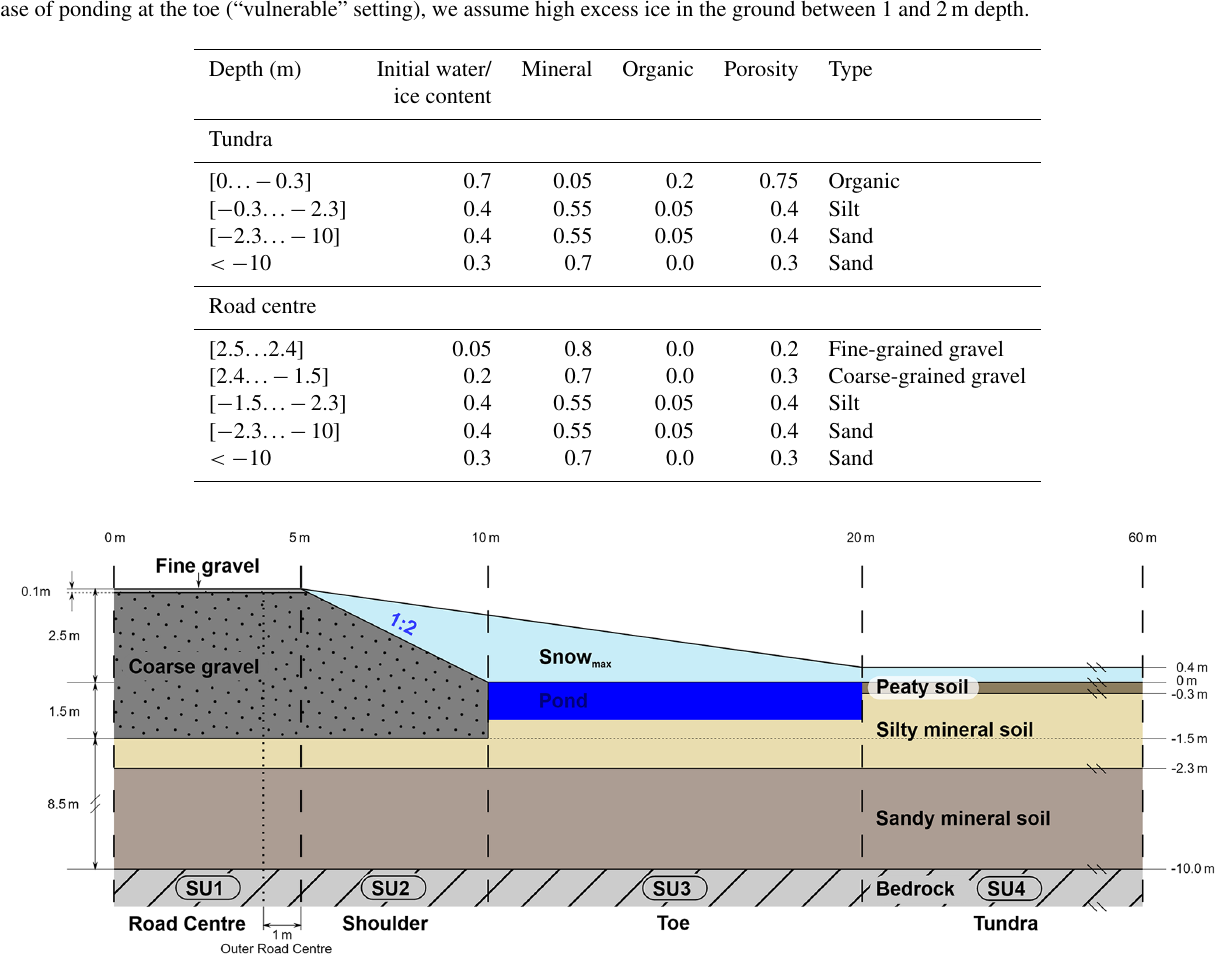
Table 1. Ground stratigraphies with volumetric fractions of the ground constituents. Negative depths correspond to layers elevated relative to the tundra surface at 0m. The setting for the road shoulder is identical to the road centre, besides lacking a fine-grained surface layer and starting from elevations between the road surface and the tundra (see Fig. 3). The road embankment base is assumed at 1.5m depth. In the case of ponding at the toe (“vulnerable” setting), we assume high excess ice in the ground between 1 and 2m depth.